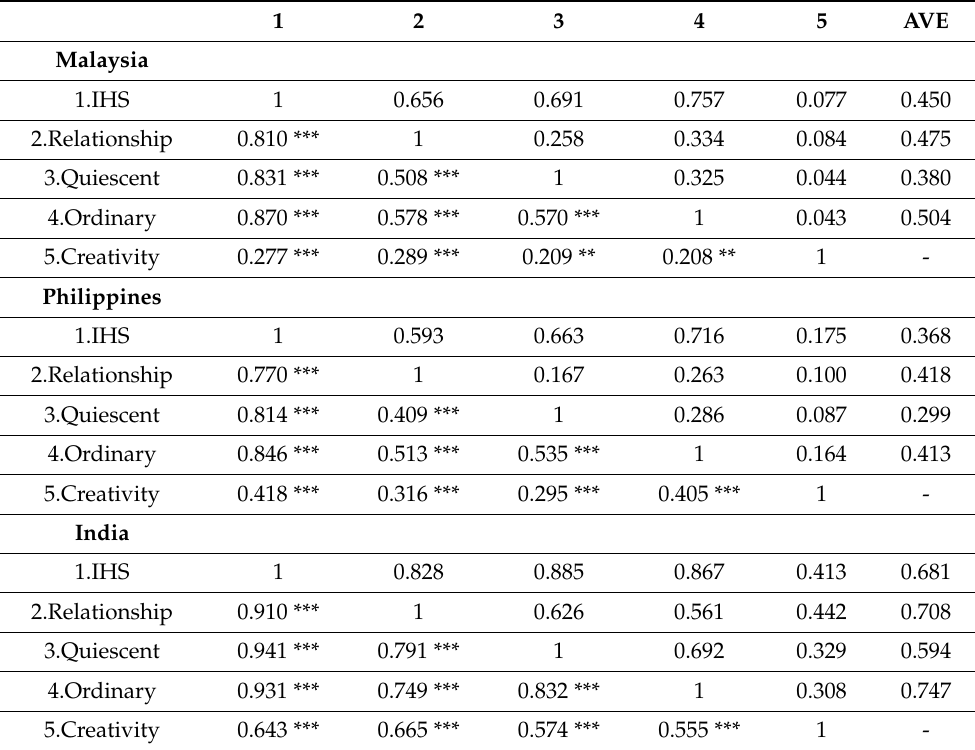
Table 3. Correlation squared correlation, and average variance extracted from the Interdependent Happiness